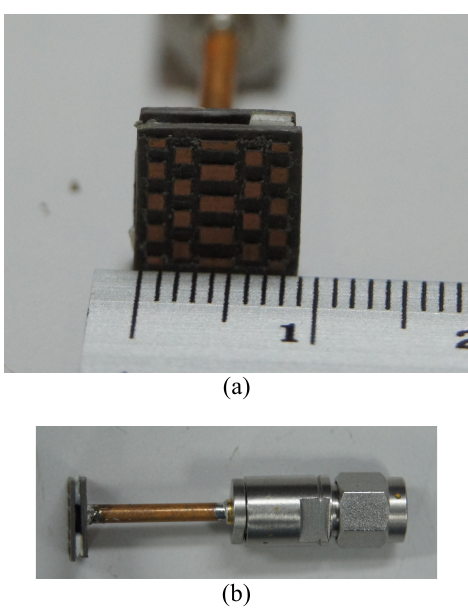
Figure 2: Prototype antenna with Port Extension (magnified